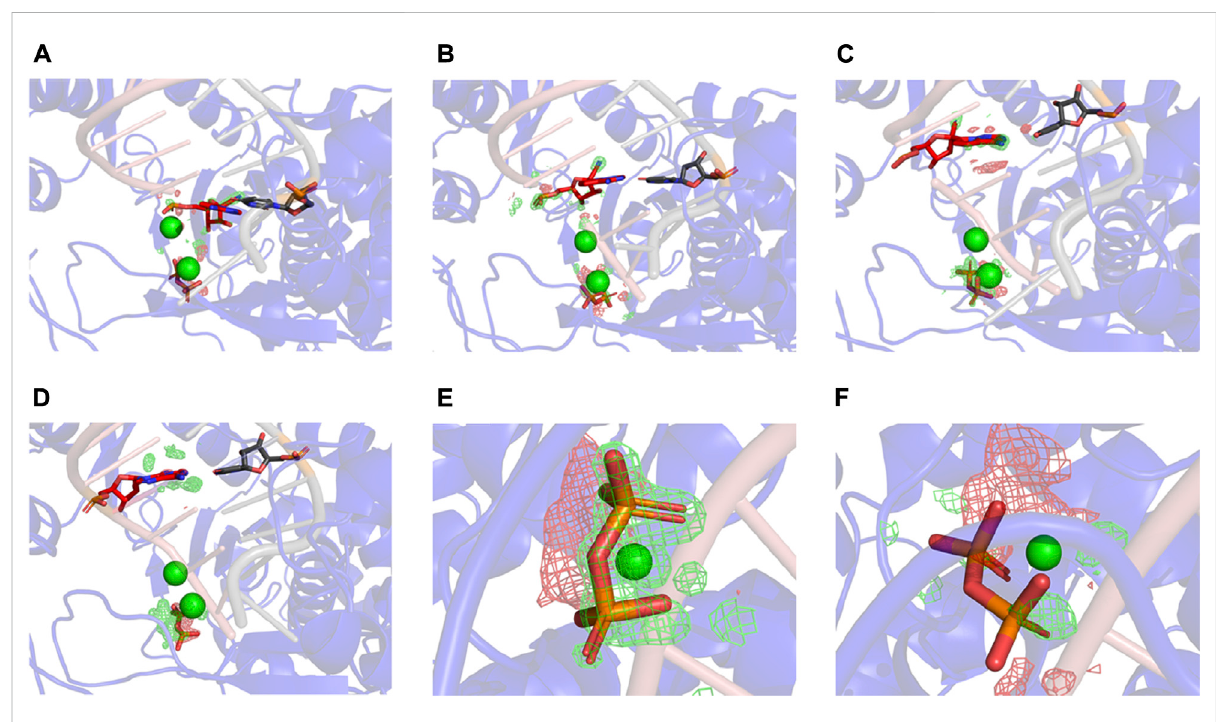
FIGURE5 DifferencesbetweenRMPandAMPcomplexesdeterminedusingdifferenceEDmaps. (A – C) DifferenceEDmapsbetweenRMPandAMPforthe three paired structures. RMP complexes are aligned to the difference map. Green mesh indicates positive and red mesh indicates negative (contoured at ± 15 σ ). (D) I +3 AMP complex aligned to the difference map. (E,F) Close-up views of PPi of i + 3 and i + 2